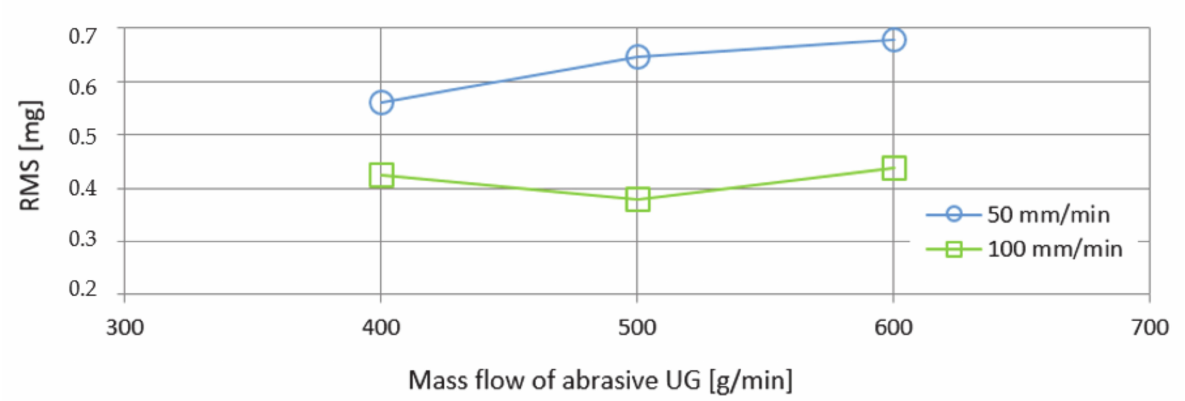
Figure 11. Graphical dependence of RMS on mass flows of abrasive UG.